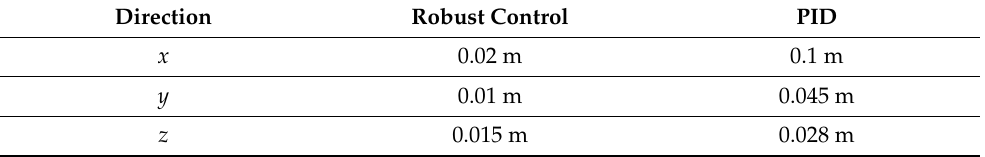
Table 3. Trajectory tracking error in x , y , and z direction. (Robust control and PID control). Direction Robust